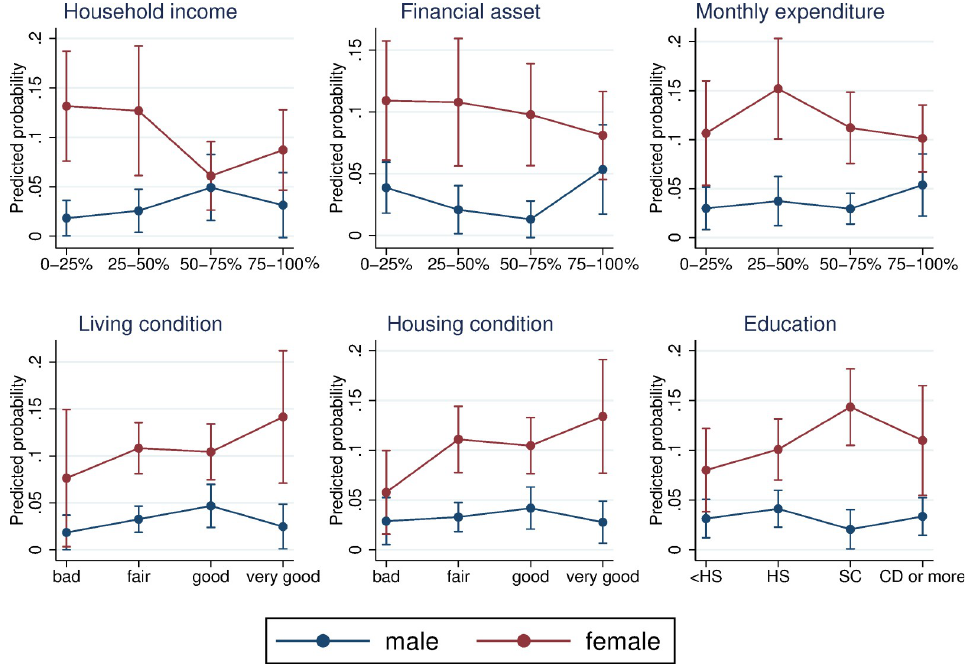
Fig 3. Predicted probability of care provision considering heterogeneous survival probability. The figure shows the predicted probability of care provision to parents using the inverse probability weighting. The bars represent the 95% confidence interval. In the first stage, age, age squared, gender, marital status of respondents, and year effects are included as dependent variables. The first stage was based on all the respondents. In the second stage, working status was also included, and the sample of the analysis consisted of those whose parents were alive. Each panel shows a different SES measure. The number of observations ranges from 1,710 (household income) to 3,551 (living and housing